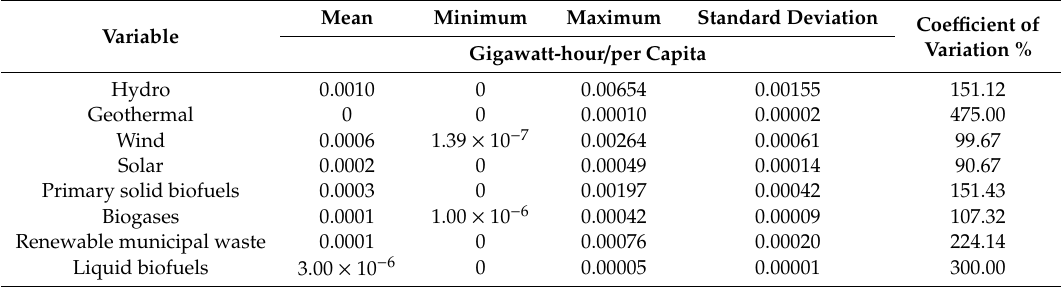
Table 7. Basic statistical parameters of variables determining the volume of energy production from renewable energy sources in the EU countries in 2017 per capita (own study).